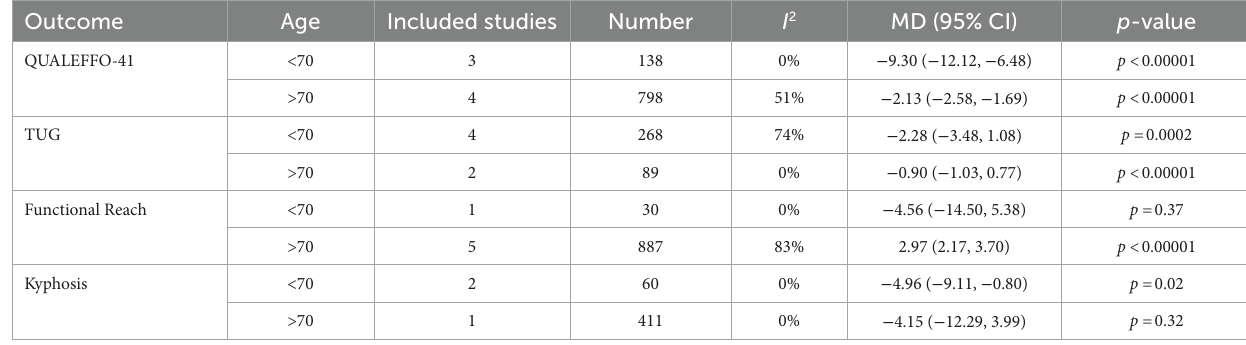
TABLE 2 Subgroup analysis by age.